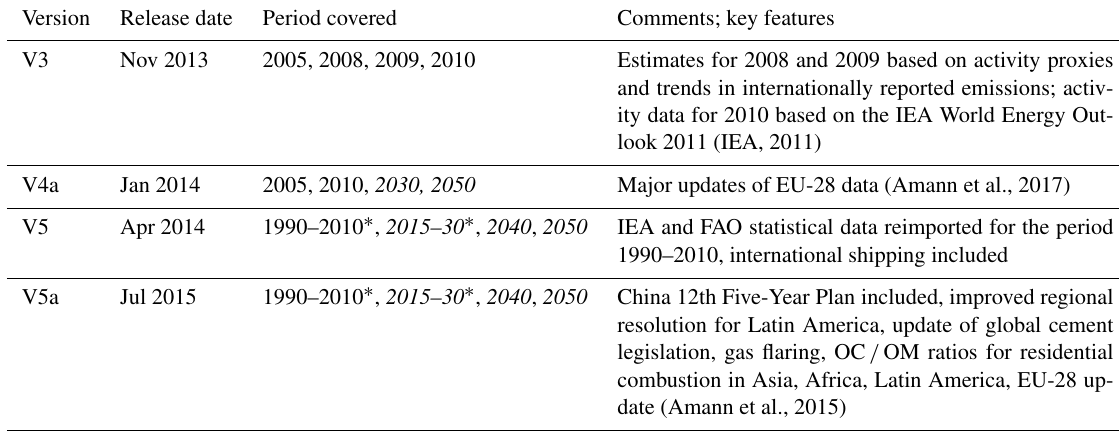
Table 1. Overview of the ECLIPSE emission datasets available to date. Time period given in italic font indicates projection